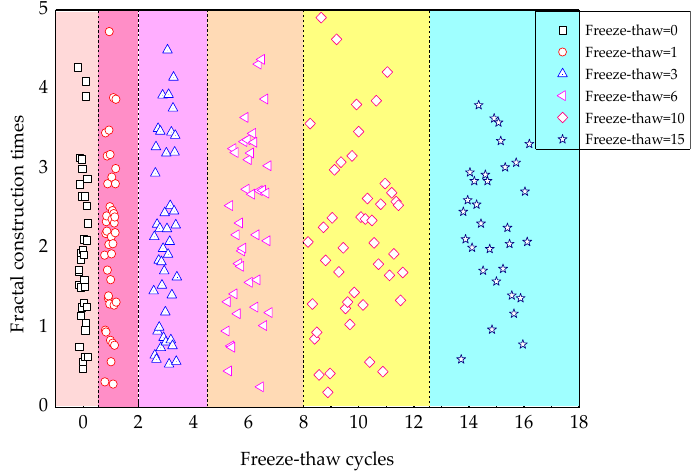
Figure 13. The change of fractal construction times with freeze-thaw